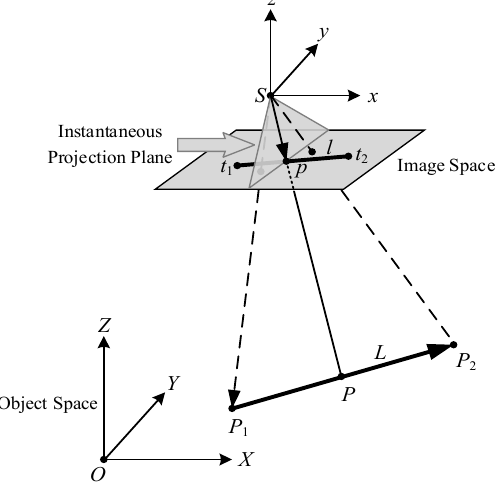
Figure 1. Imaging sketch map of linear